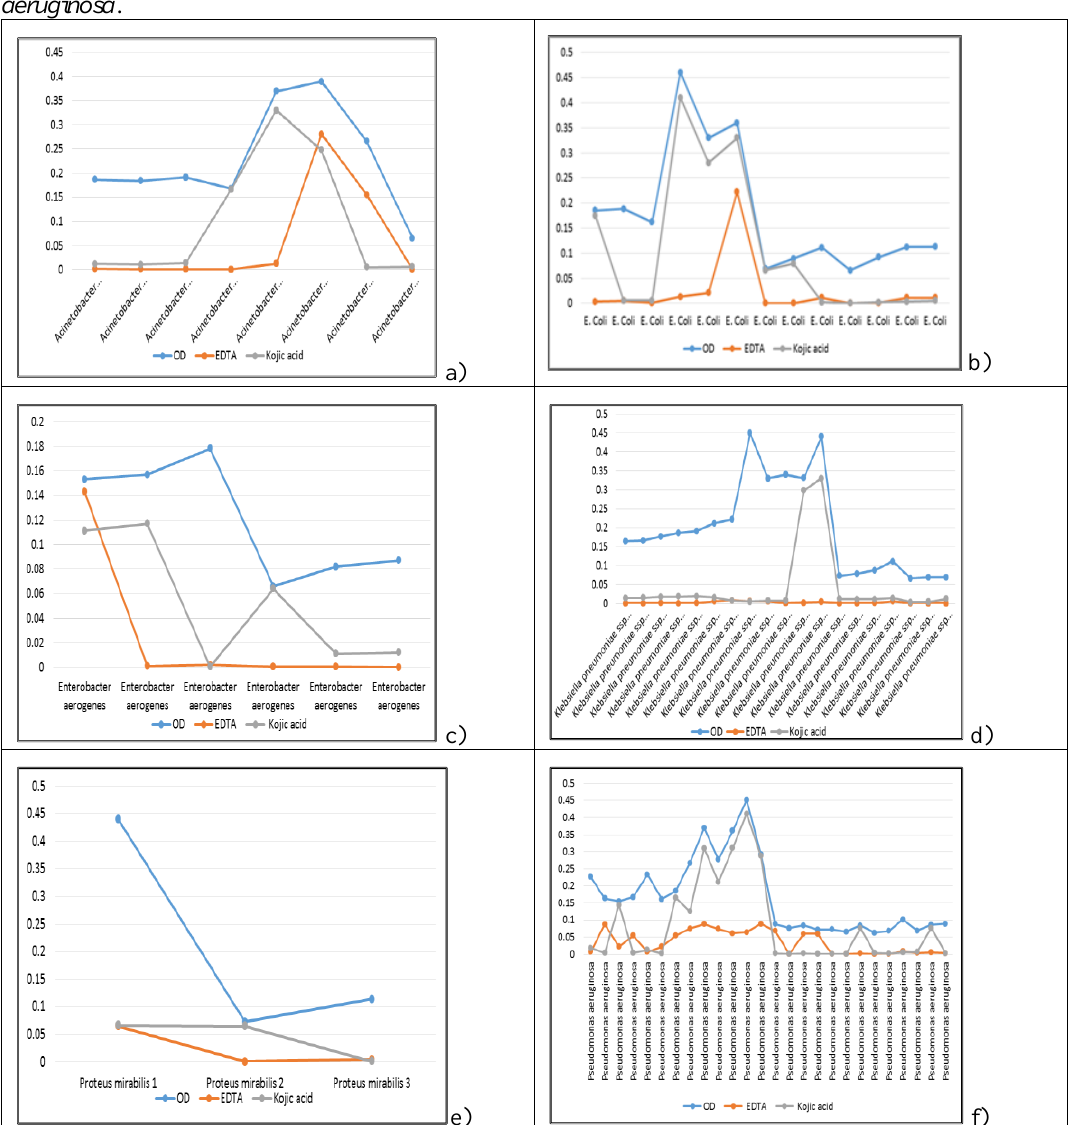
Figure 5. Optical density readings of biofilm-producers before and after exposure to CuO NPs; a) Acinetobacter baumannii , b) E. Coli , c) Enterobacter aerogenes , d) Klebsiella pneumonia , e) Proteus mirabilis , f) Pseudomonas aeruginosa